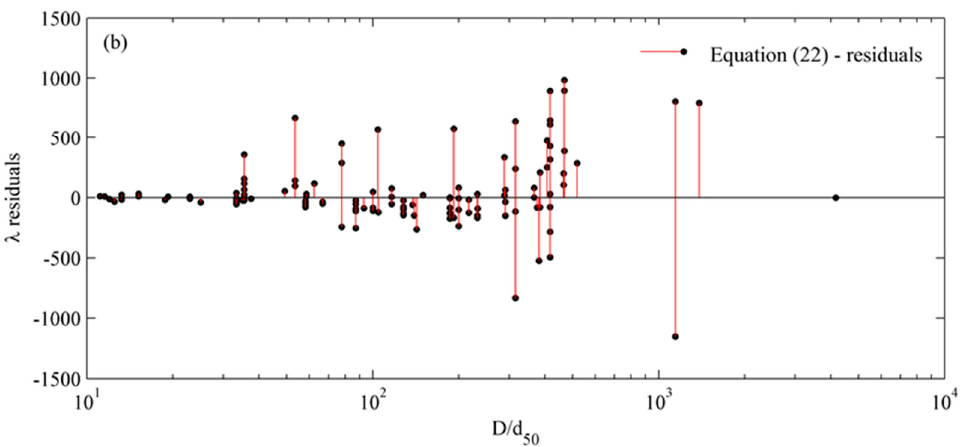
Figure 5. ( a ) (cid:2019) values in function of (cid:1830) (cid:1856) 50 ⁄ ; ( b ) Residual values for (cid:2019) in comparison with estimated Figure 5. ( a ) λ values in function of D / d 50 ; ( b ) Residual values for λ in comparison with estimated values using Equation (18). values using Equation (18).